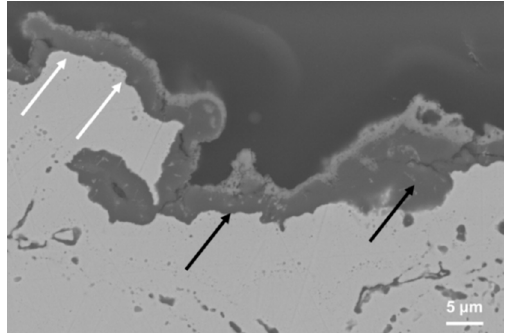
Figure 7. Cross sectional SEM microstructure of oxidized NiCoCrAlYRe coating showing the formation of a double oxide scale on the top-surface, composed of an inner continuous Al 2 O 3 scale supported by an upper mixed oxide